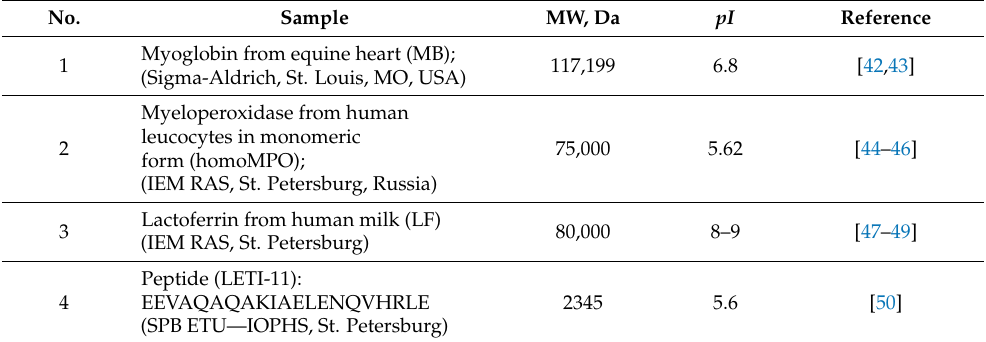
Table 1. Proteins and peptide investigated and their